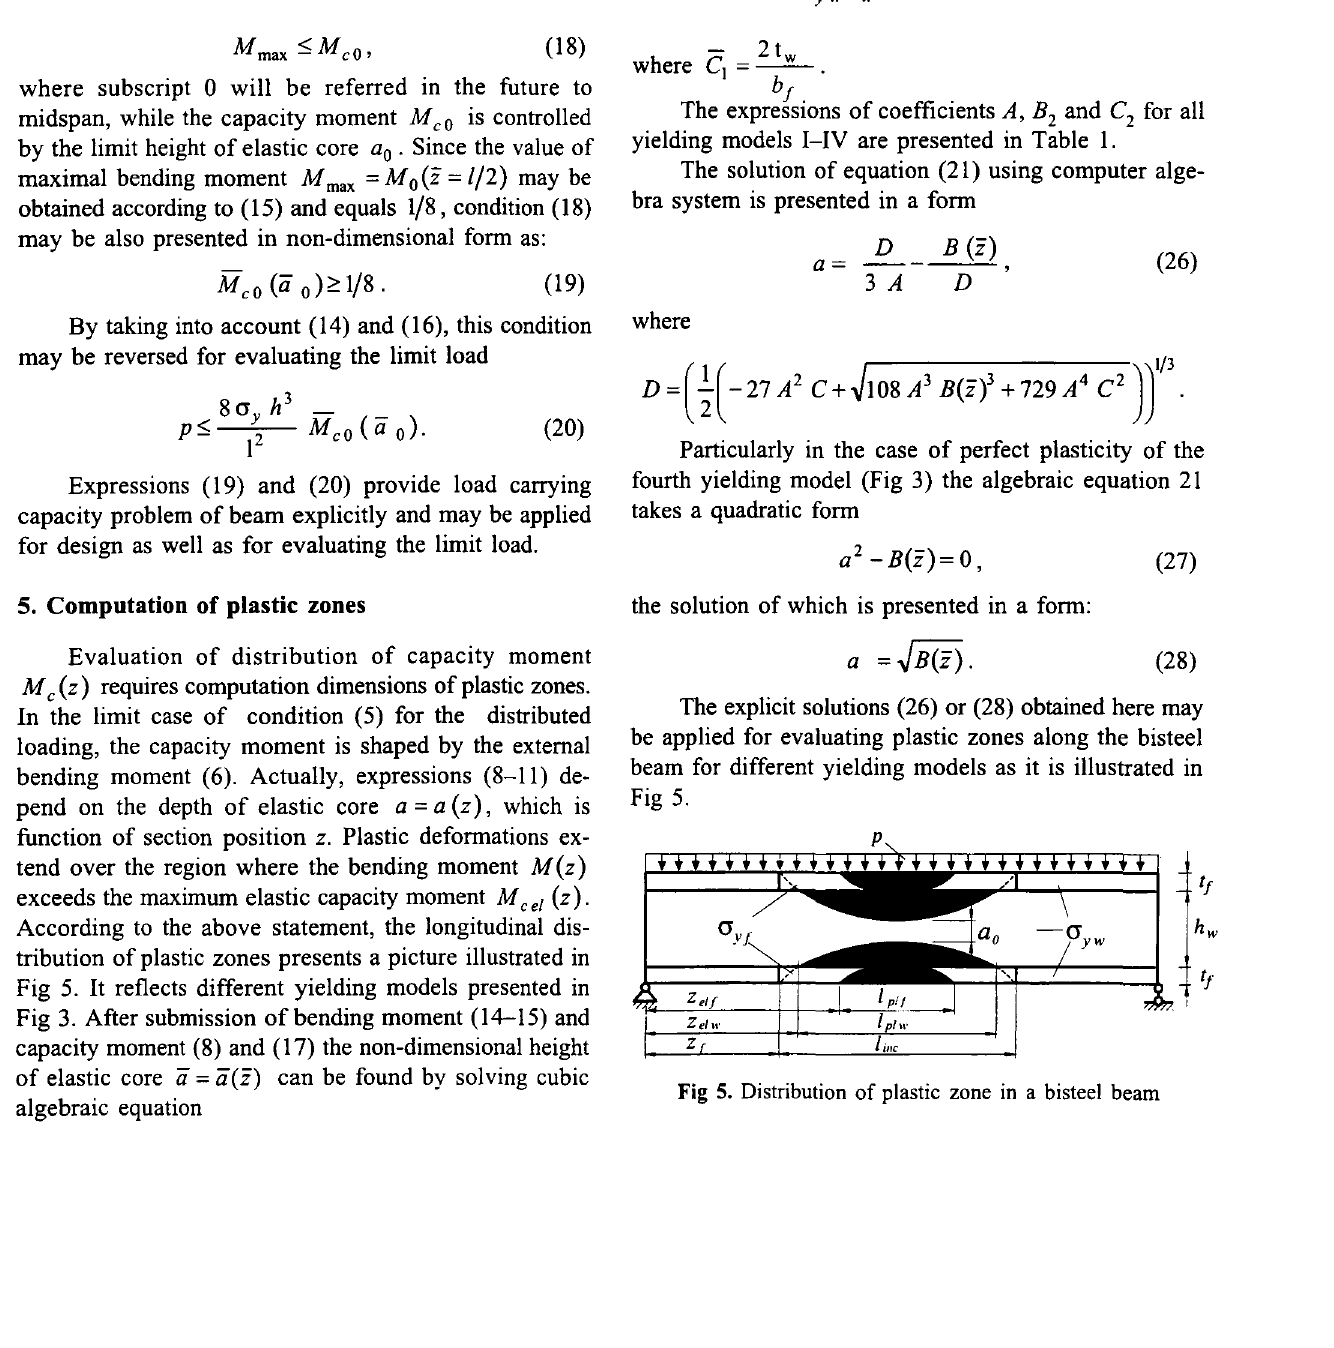
Fig 4. Diagram M co = f(co)